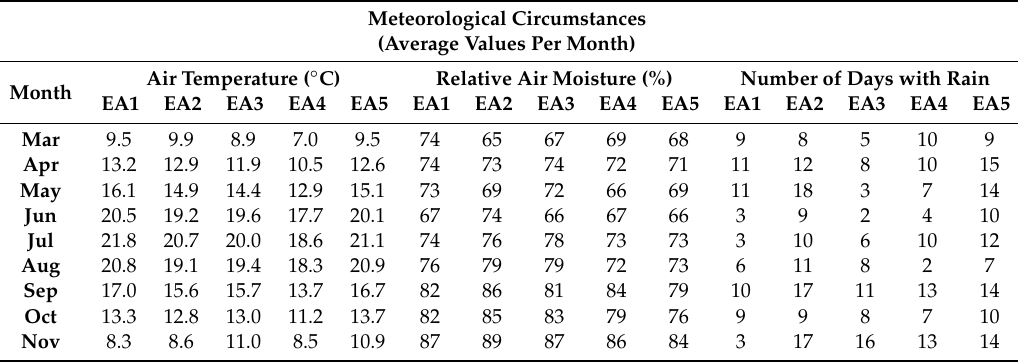
Table 2. Meteorological conditions at di ff erent